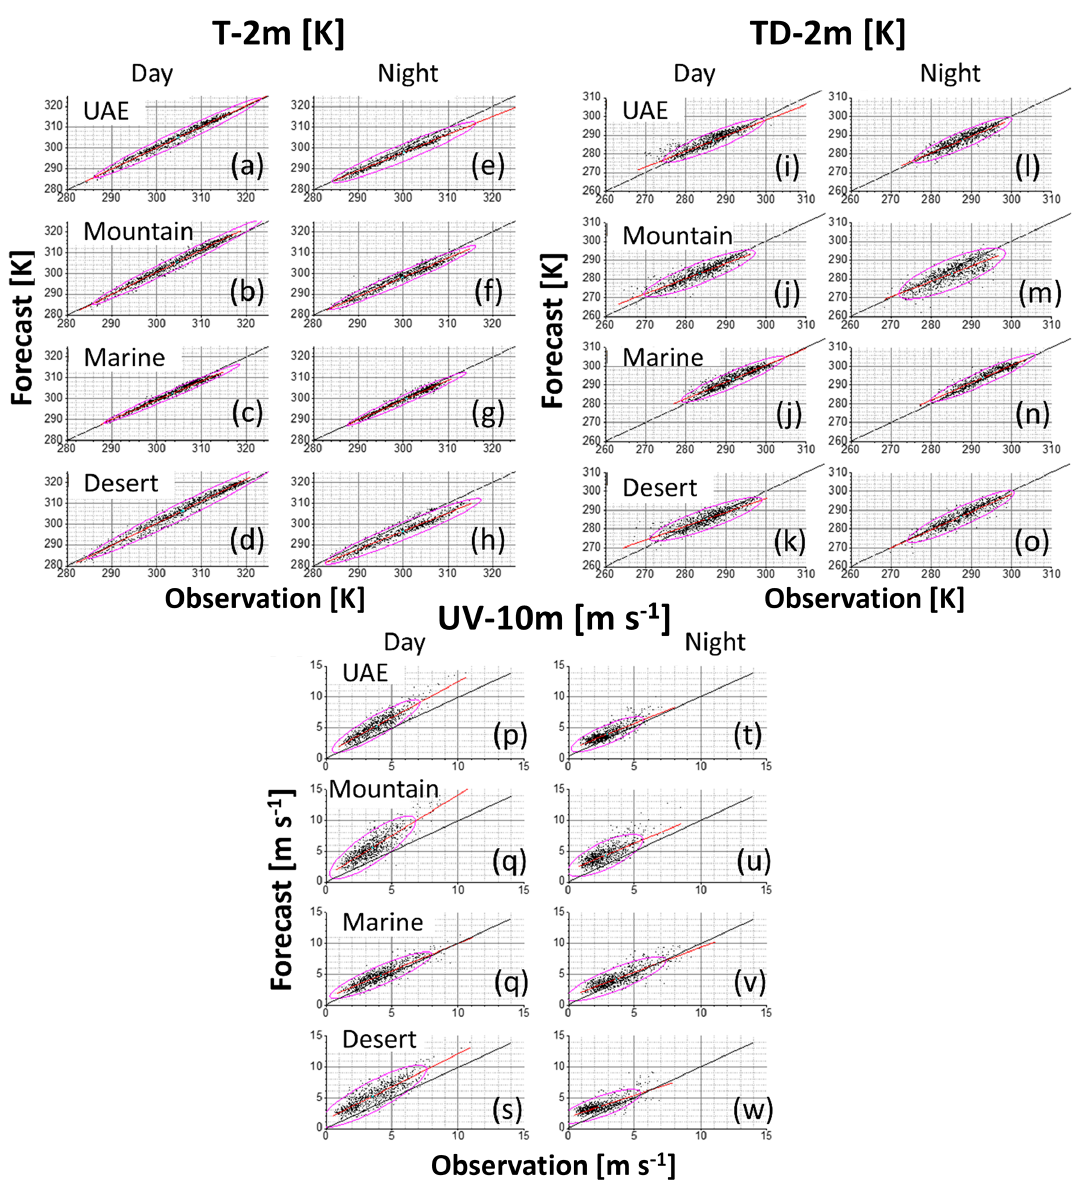
Figure 5. Scatter plots of forecast vs. observation for all time steps over the period of January–November 2015, comparing each weather station at the corresponding WRF grid point. The plots are split by daytime (06:00–17:00LT, left panels) and nighttime periods (18:00– 05:00LT, right panels), and by region (UAE, mountain, marine, desert). The variables compared are 2m air temperature ( T 2m , K) in panels (a) – (h) , 2m dew point (TD 2m , K) in panels (i) – (o) , and 10m wind speed (UV 10m ,ms − 1 ) in panels (p) – (w) . Also shown is a line of best fit (red), a line of perfect fit (black), and 95% confidence ellipse